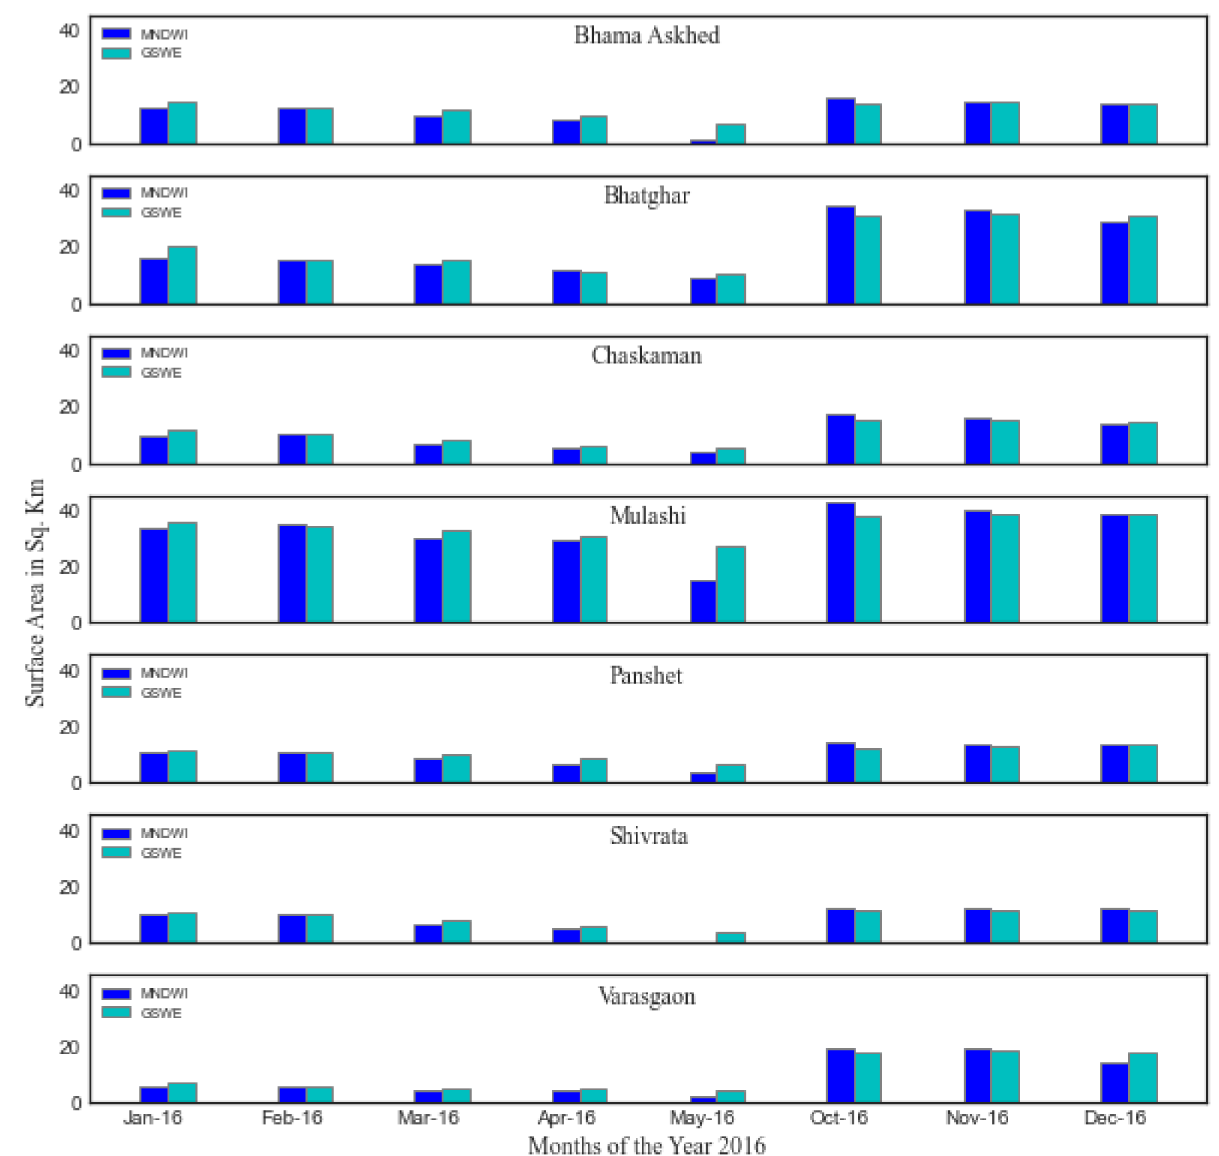
Figure 10. Comparative representation of surface area of distinct reservoirs in study area calculated by Modified Normalized Difference Water Index (MNDWI) and Global Surface Water Explorer (GSWE)